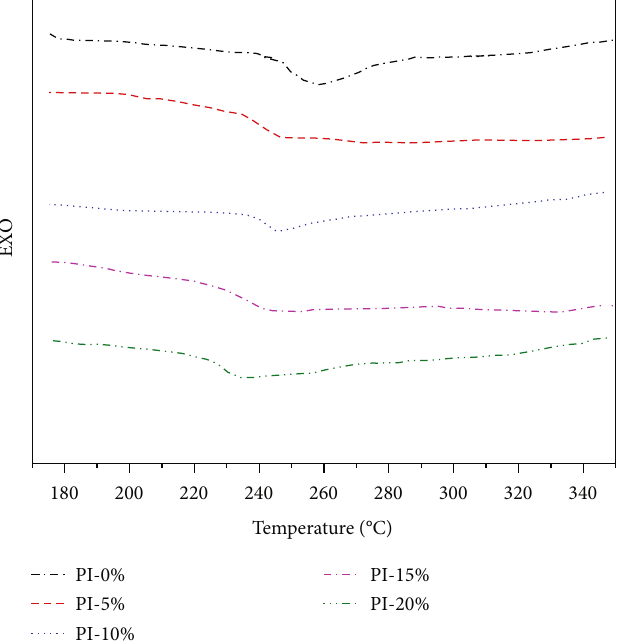
Figure 7: DSC curves of PIFs with di ff erent HMDA